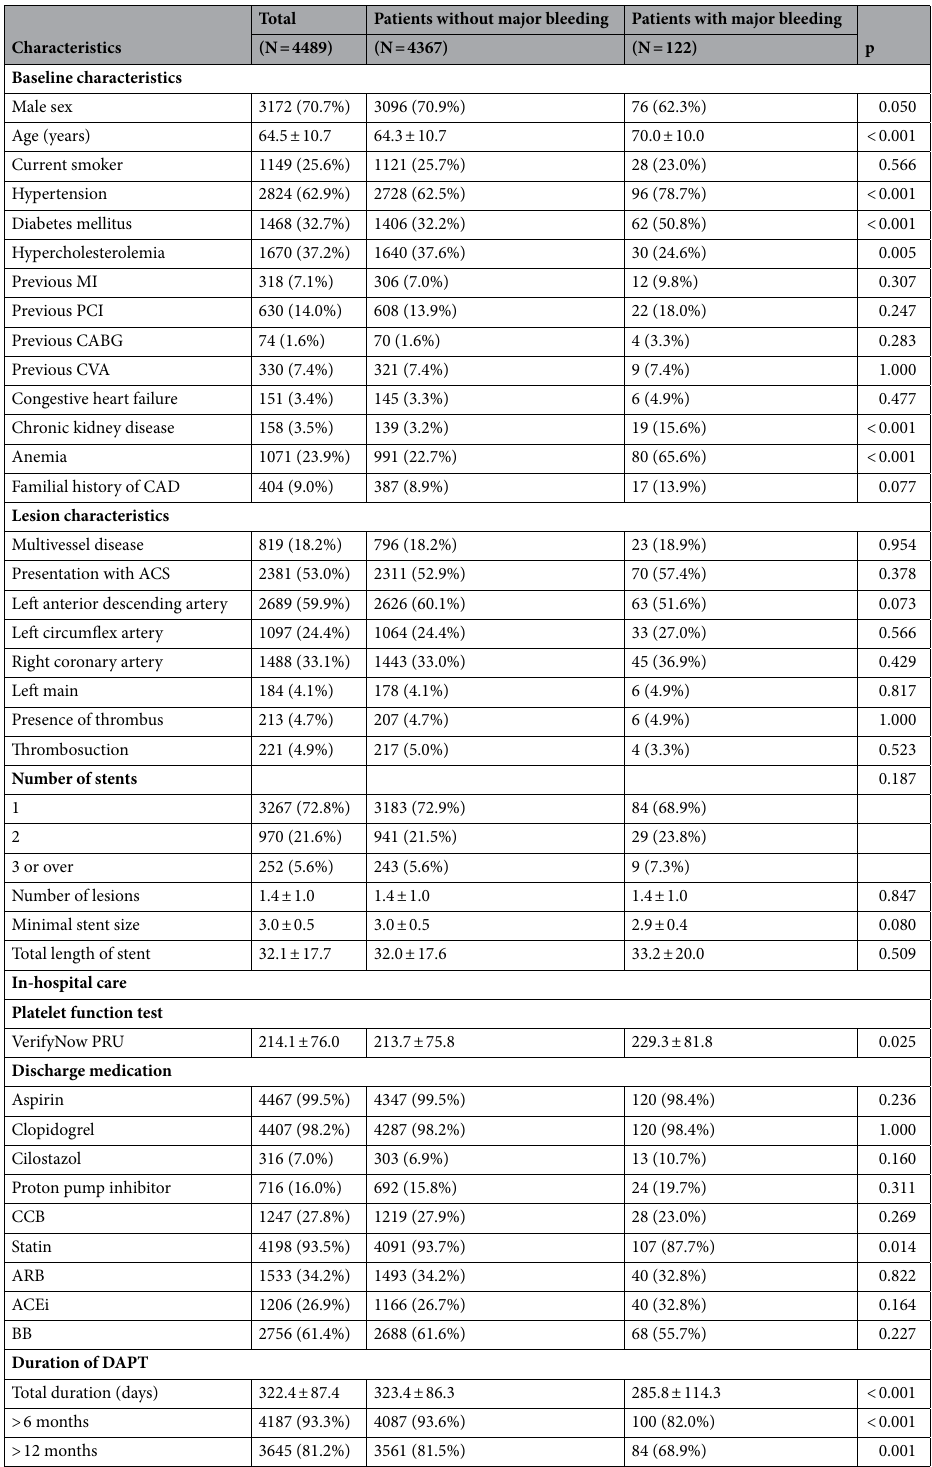
Table 1. Patients’ baseline and lesion characteristics and characteristics of in-hospital care. Data are presented as number (%) or mean (standard deviation). ACS acute coronary syndrome, MI myocardial infarction, PCI percutaneous coronary intervention, CABG coronary artery bypass graft, CVA cerebrovascular accident, CAD coronary artery disease, PRU P2Y12 reaction unit, DAPT dual antiplatelet